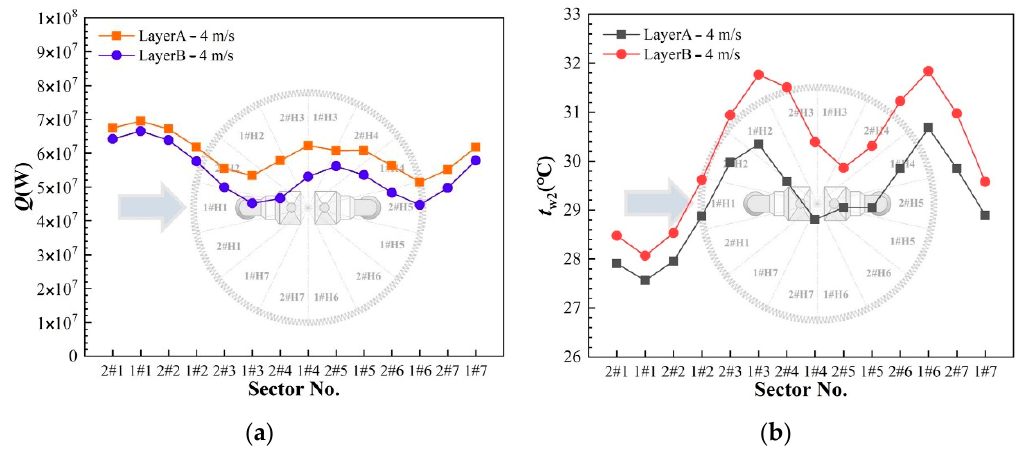
Figure 11. Comparison of temperature fields of ACHE in the absence of wind in the cases of 2 units and 1 unit.